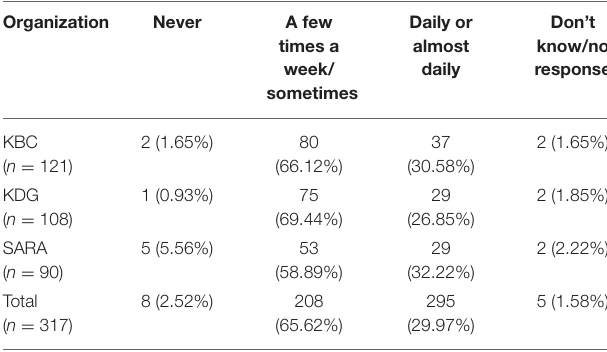
TABLE 3 | Frequency of using the skills or advice in the “changing unhelpful thoughts”